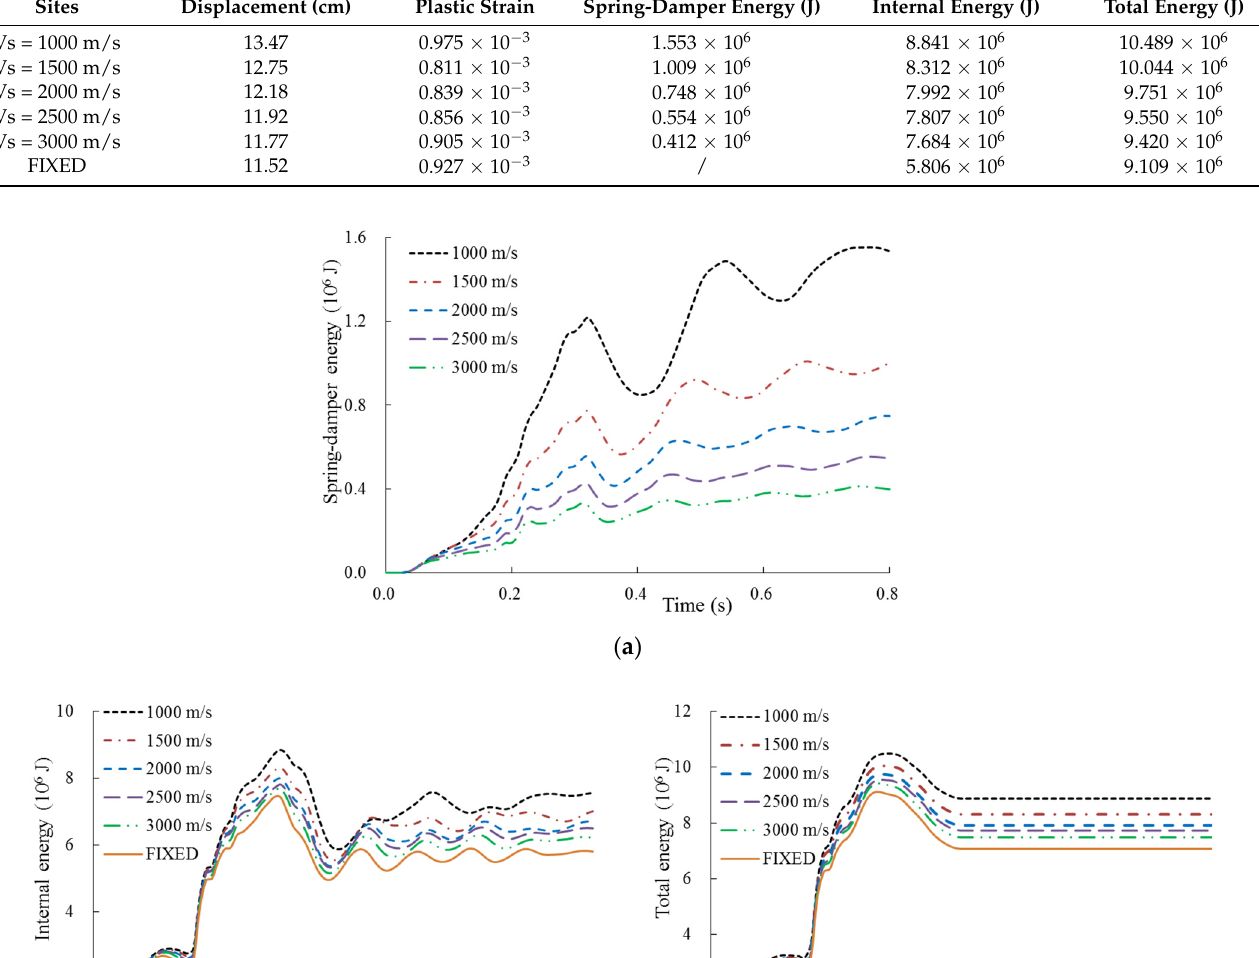
Table 5. The peak displacement, plastic strain, spring-damper energy, internal energy, and total energy.